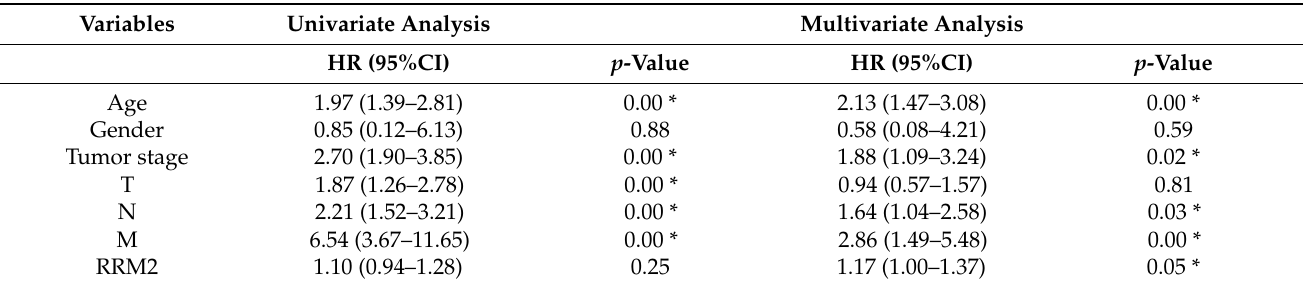
Table 1. Univariate Cox-regression analysis and multivariate Cox-regression analysis of RRM2 expression and clinicopathologic variables in TCGA BRCA